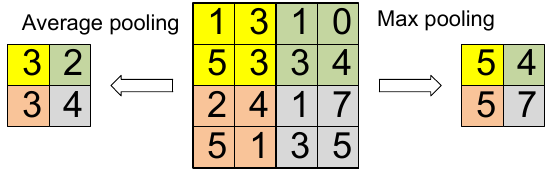
Figure 3. Different pooling functions applied to a feature